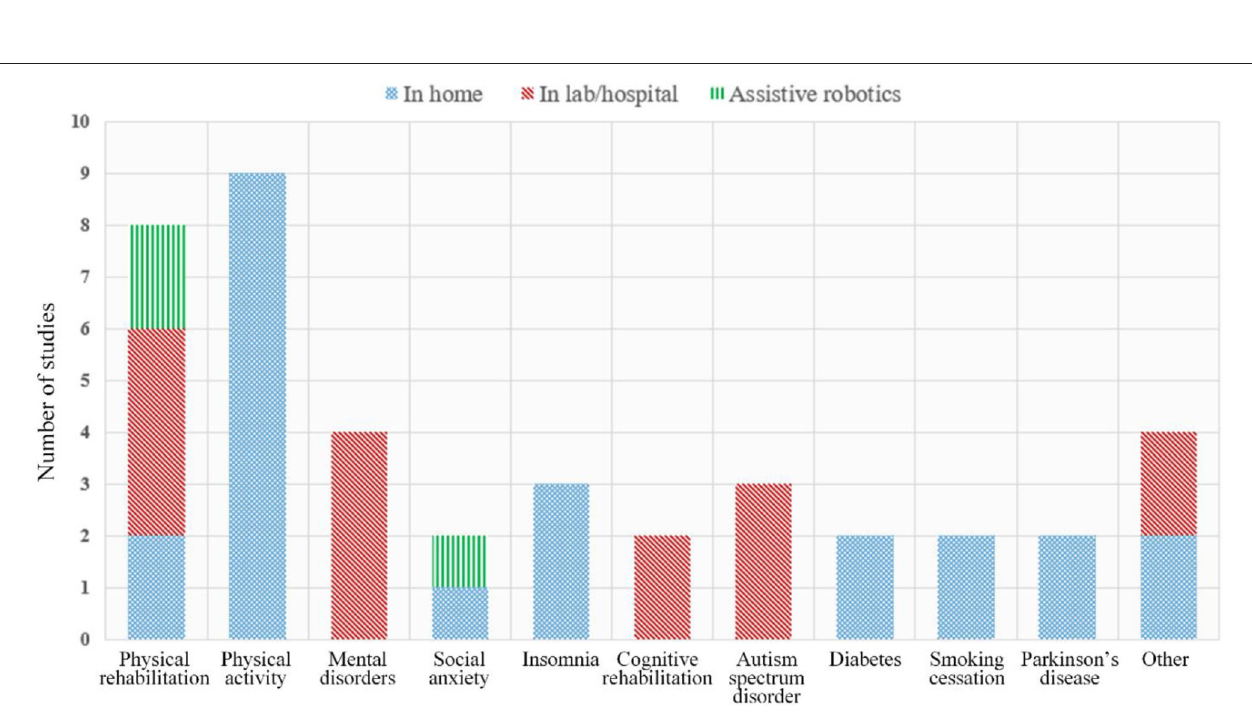
FIGURE 3 | Distribution of selected research papers according to medical domain.